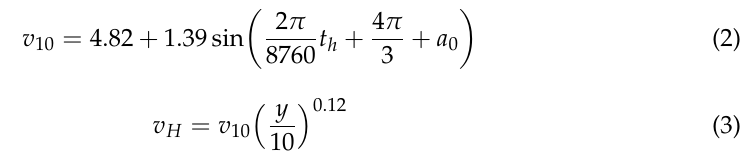
Table 4. Thermal boundary parameters of different surfaces. Parameters T 0 ( ◦ C) A Air (PF) − 3.5 11.5 Natural ground surfaces (AB and EF) − 1.0 12 Side slope surfaces (BC and DE) 1.2 13 Asphalt pavement surface (CD) 3.0